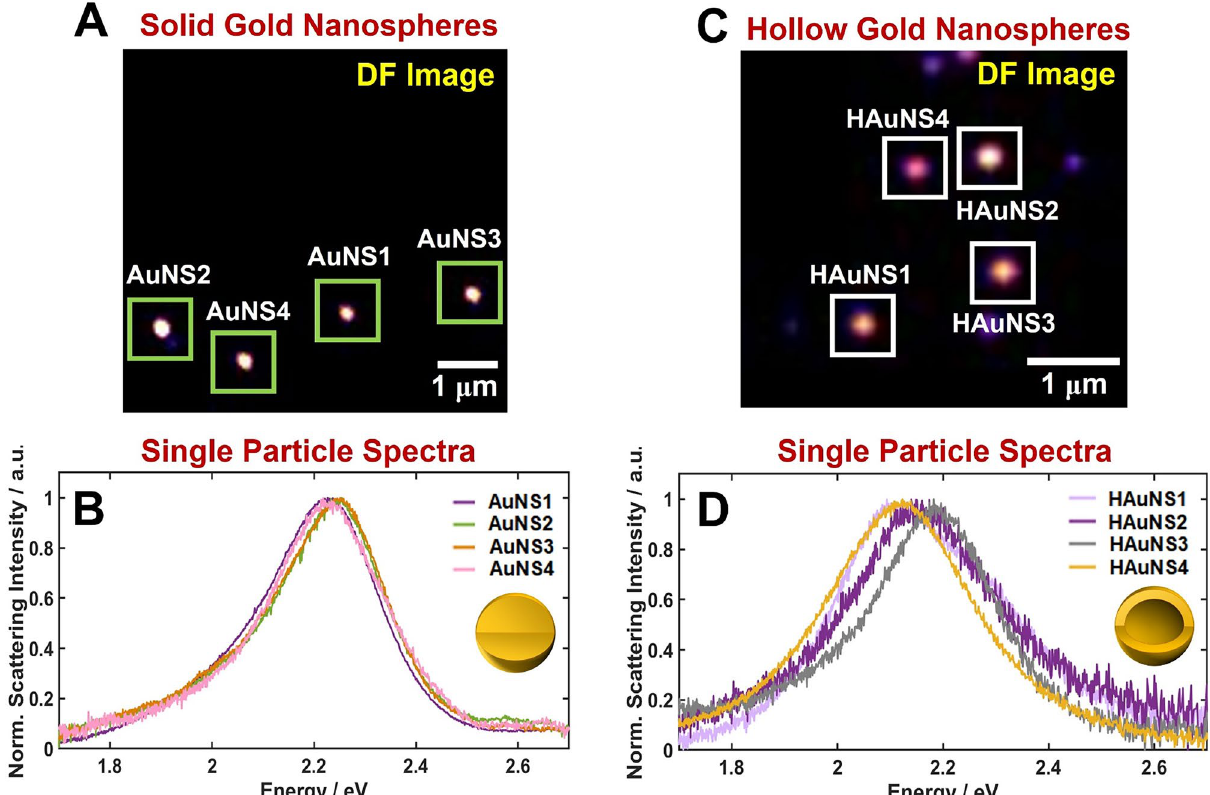
Figure 2. ( A ) Dark-field image of single AuNSs illuminated by white light. ( B ) Scattering spectra of the single AuNSs from the green square in ( A ). ( C ) Dark-field image of single HAuNSs illuminated by white light. ( D ) Scattering spectra of the single HAuNSs from the white square in ( C